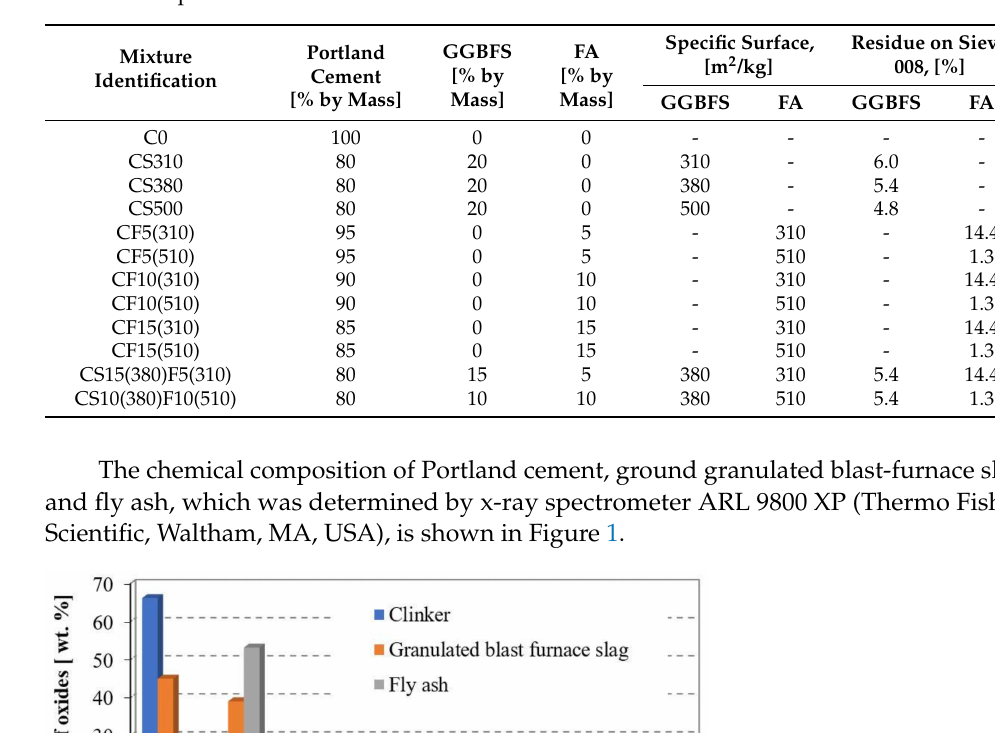
Table 3. Composition of Portland cements and the fineness of SCMs.